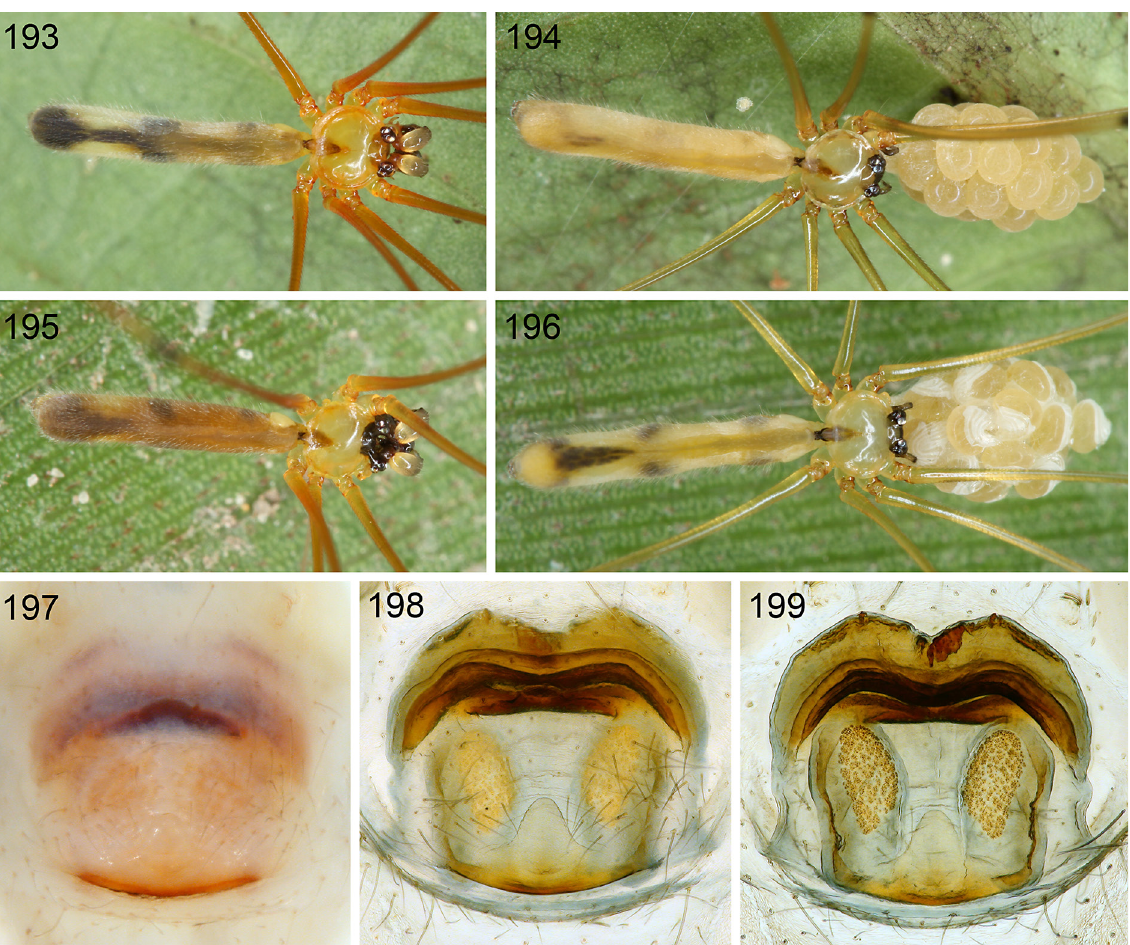
Figs 193–199. Live specimens, Pholcus andulau group, and female genitalia of Ph. lambir Huber, sp. nov. 193–194 . Pholcus andulau Huber, 2011, ♂ and ♀ with egg-sac from Gunung Mulu, Sarawak. 195–196 . Ph. lambir sp. nov., ♂ and ♀ with egg-sac from Lambir, Sarawak. 197–199 . Ph. lambir sp. nov., female genitalia, untreated in ventral view, cleared in ventral and dorsal